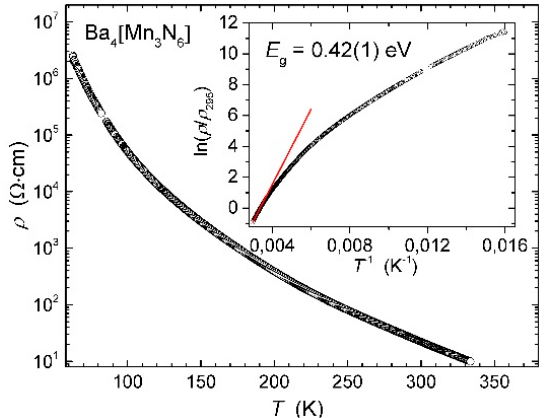
Figure 4. Temperature dependence of electrical resistivity for polycrystalline Ba 4 [Mn 3 N 6 ]. Inset: ln( ρ / ρ 295 ) vs. T − 1 plot (circles) with a linear fit (red line).